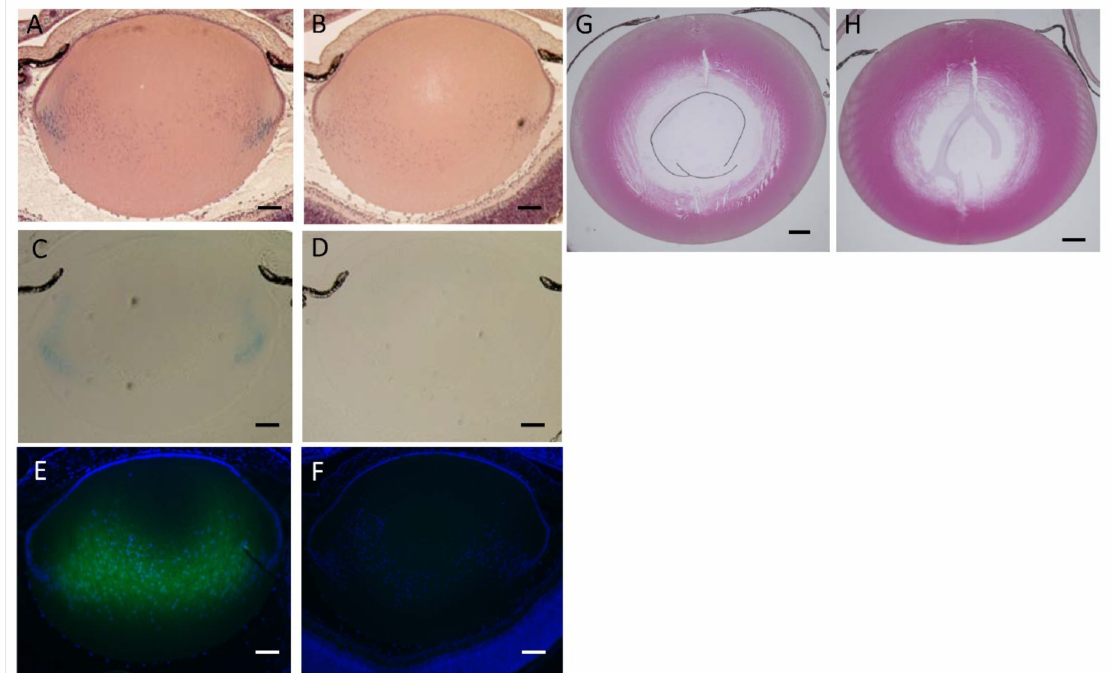
Figure 5. β -Galactosidase expression and histochemical analysis of lenses in hDCN-Tg animals. The findings regarding lens tissue in hDCN-Tg ( A ) newborn mice (PD1) did not differ from those in WT ( B ). ( C ) Lens images showing the expression of β -galactosidase in the anterior epithelial cells and primary lens fiber cells of the newborn hDCN-Tg mouse lens, revealed by X-gal staining. ( D ) Control sections from WT mice at PD1 were not stained with X-gal. ( E ) DCN was strongly immunostained in the lens fiber of the hDCN-Tg animal at PD1, suggesting that DCN secreted from LECs perfused into the lens fiber. ( F ) DCN immunostaining signal was undetectable or negative at PD1 in the lens of WT mice at PD1. Adult lenses in 25-week-old hDCN-Tg animals ( G ) did not show lens fiber damage and epithelial cell changes and did not differ from those in WT ( H ). Scale bar = 200 µ m in a,b,c,d,e, and f; 100 µ m in g and